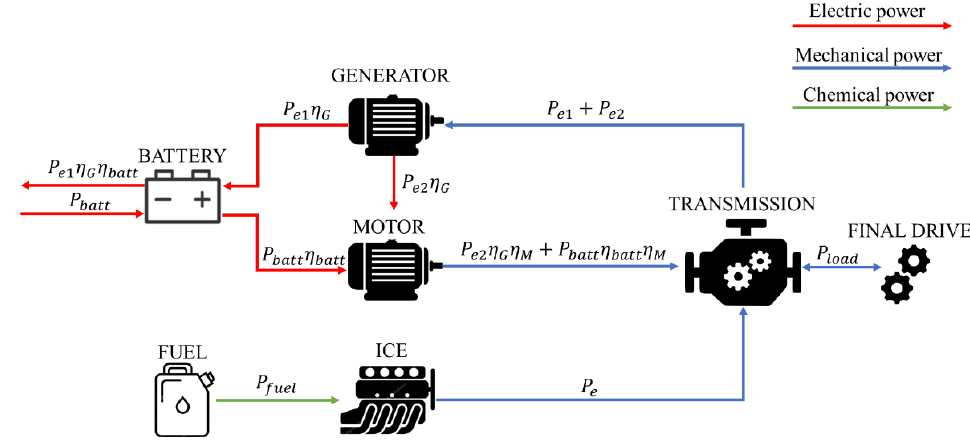
Figure 3. Generic scheme of the power flow for a hybrid powertrain.